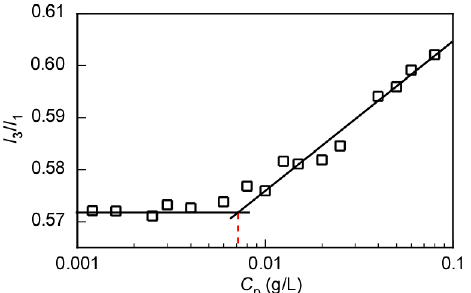
Figure 9. Fluorescence intensity ratio ( I 3 / I 1 ) of pyrene in the presence of P(MEA / MPC 6 ) plotted against the polymer concentration ( C p ). I 3 and I 1 are the fluorescence intensities of the third and the first vibronic peaks, respectively, in the pyrene emission spectra recorded at the excitation wavelength of 334